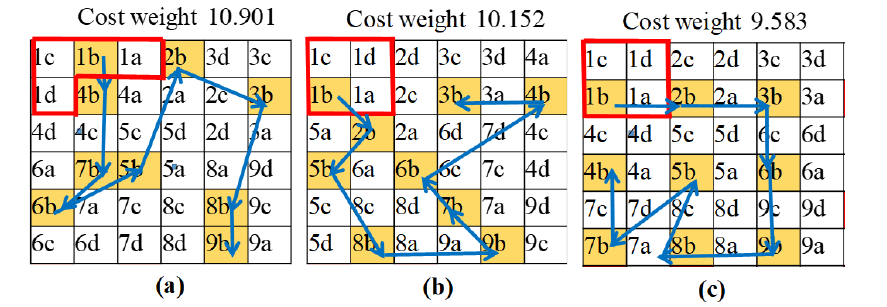
Figure 16. Paths generation for different tilesets with the same 6 × 6 workspace. ( a ) Optimal path consisting of L, S, J, O, Z; ( b ) Optimal path consisting of O, I J, L; ( c ) Optimal path consisting of only